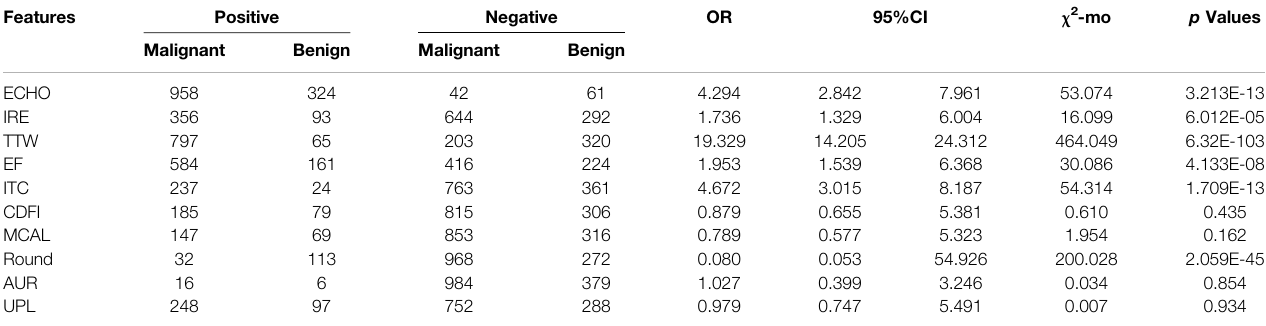
TABLE 1 | Association between ten ultrasound characteristics and PTC thyroid malignancy in the bivariate analysis ( n (cid:1) 1,385).